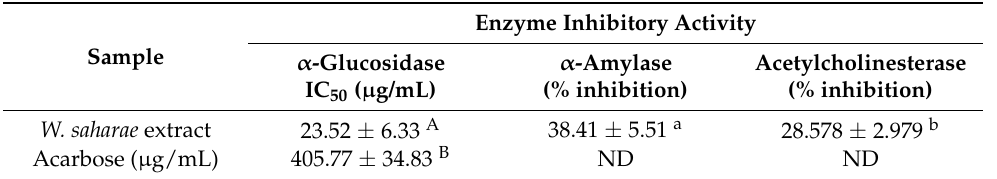
Table 4. Enzyme inhibition activities of W. saharae extract and standards (IC 50 value corresponded to the concentration of 50%